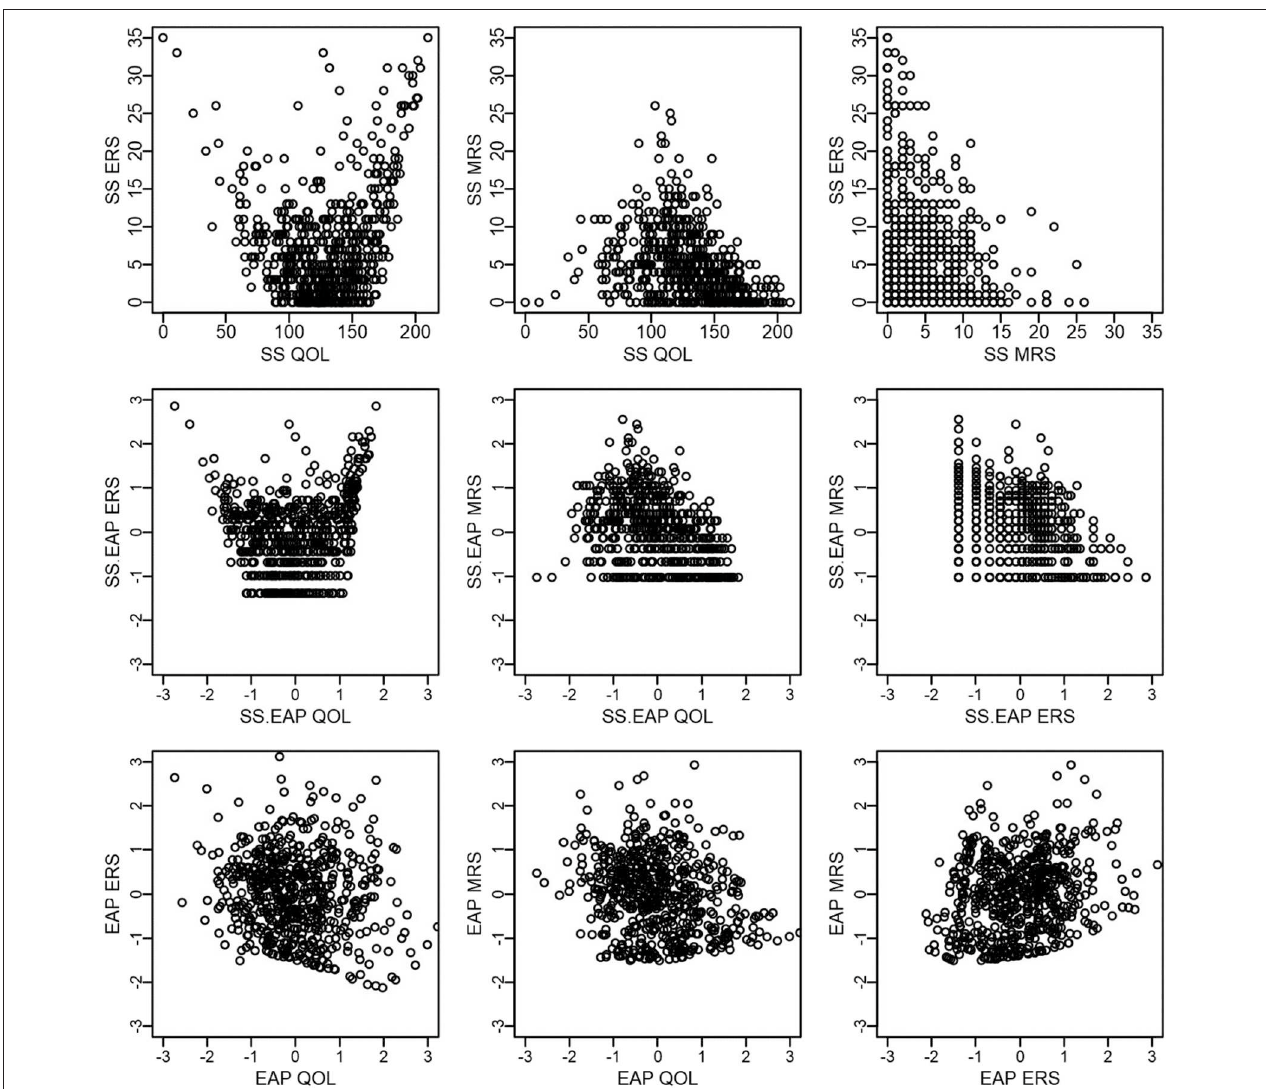
FIGURE 4 | Scatter plots of QOL, ERS, and MRS scores within each scoring